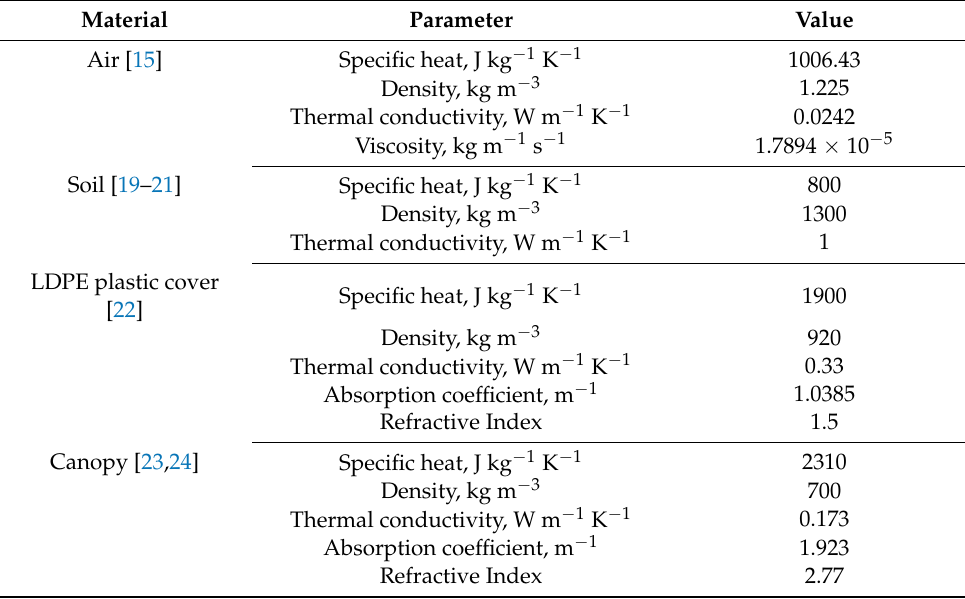
Table 3. Material properties used during the CFD